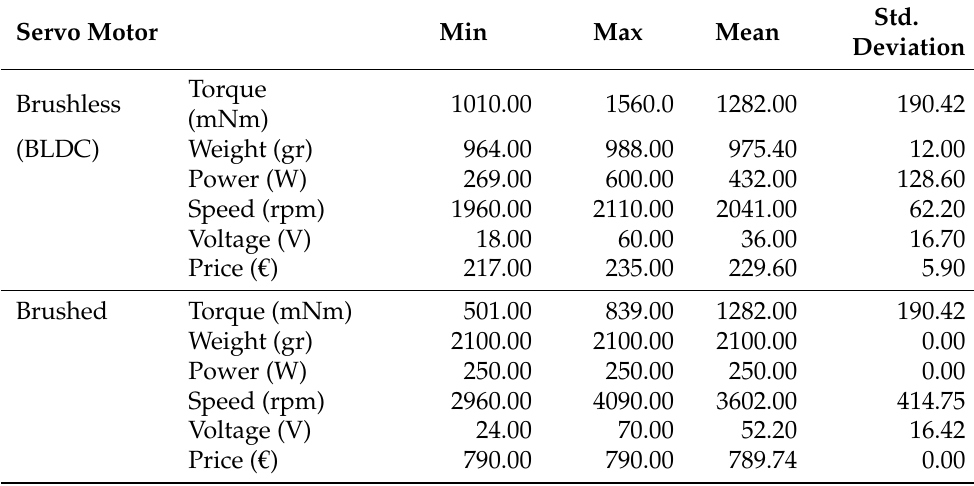
Table 7. Comparison Quantitative Characteristics: Brushless (BLDC) and Brushed Motors. Servo